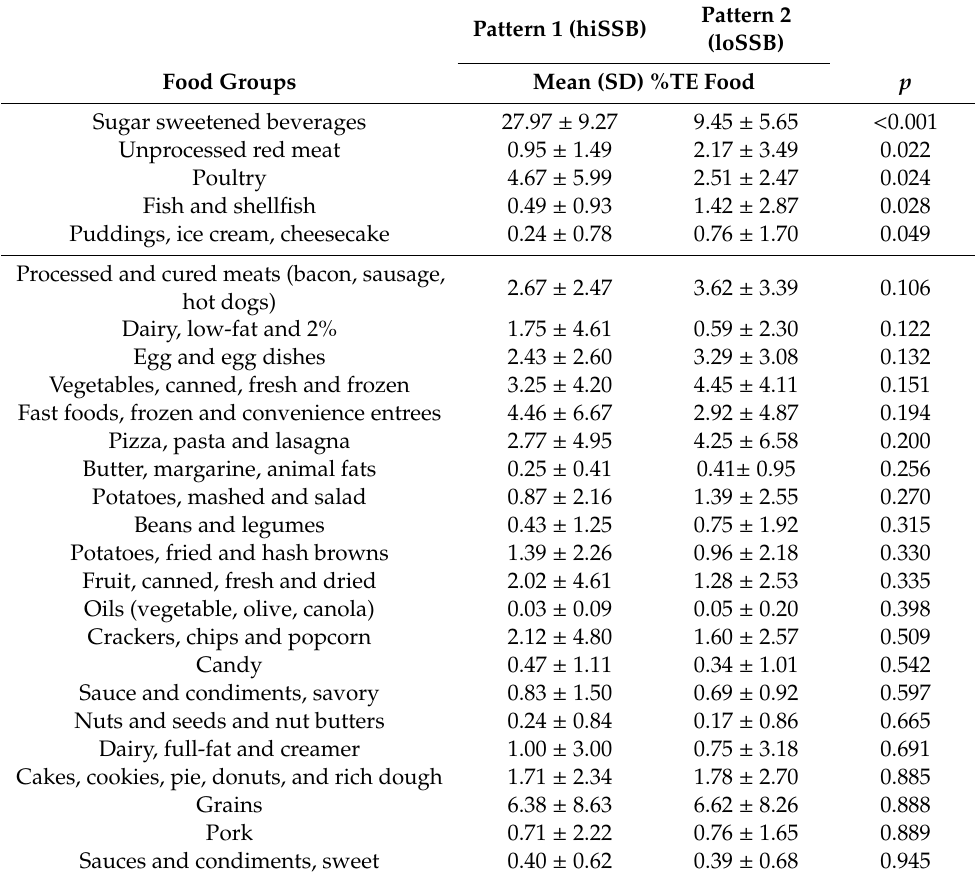
Table 1. Percentage of energy contribution of food